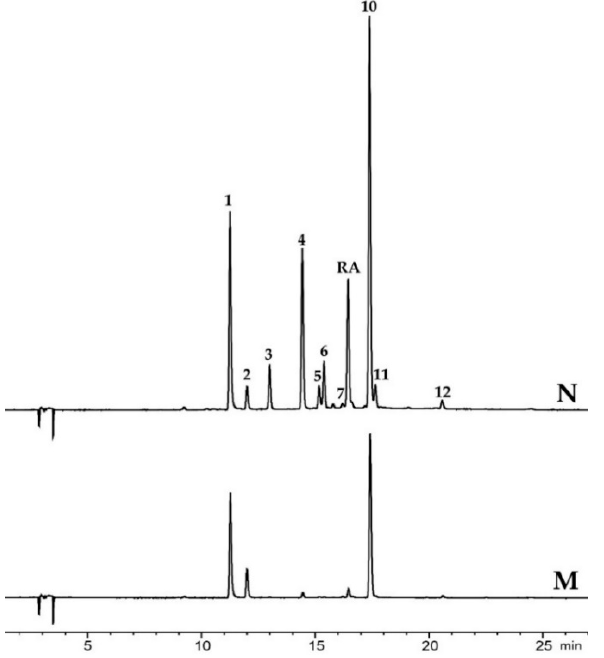
Figure 2. HPLC-DAD chromatograms recorded at 360 ± 20 nm for the two northernmost Zostera marina samples (~70° N, 27° E; M; Munkefjorden, N; Rafsbotn).